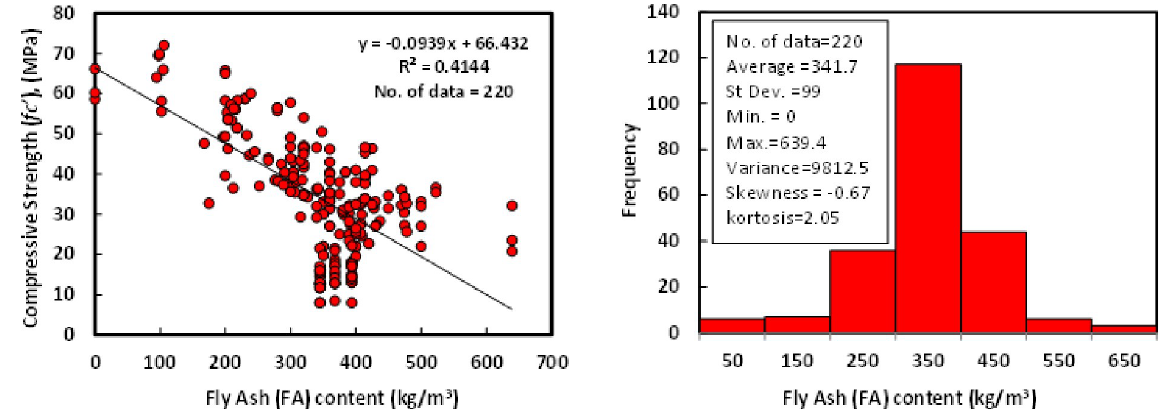
Fig 3. Relationship and a histogram of compression strength versus fly ash content of GGBS/FA-GPC.